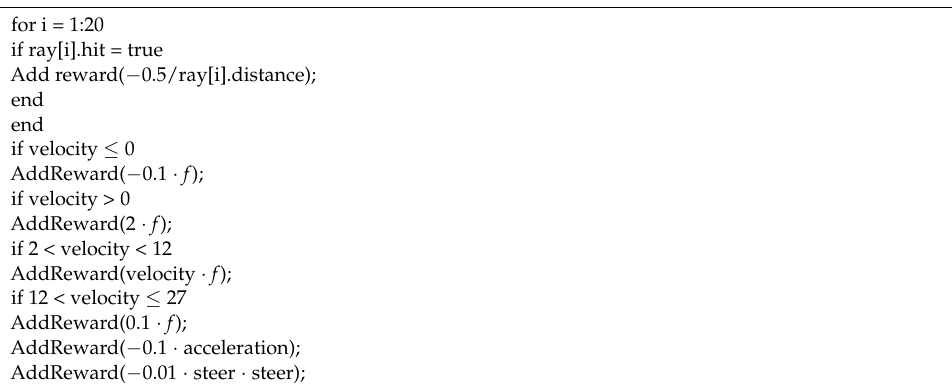
Algorithm 1 Award accumulated in each IA’s observation-action